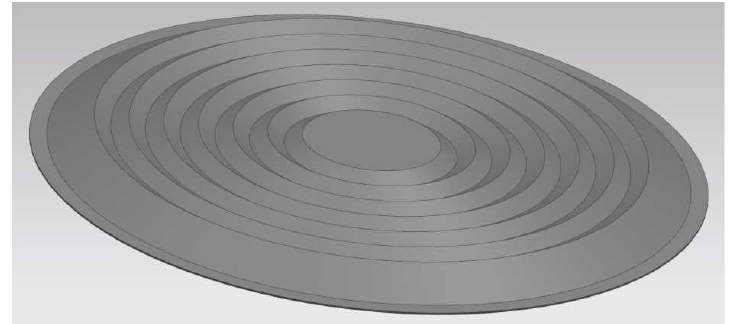
Table 1. Parameters of the diaphragm. Figure 6. The 1:1 scale 3D model of the elastic corrugated diaphragm.